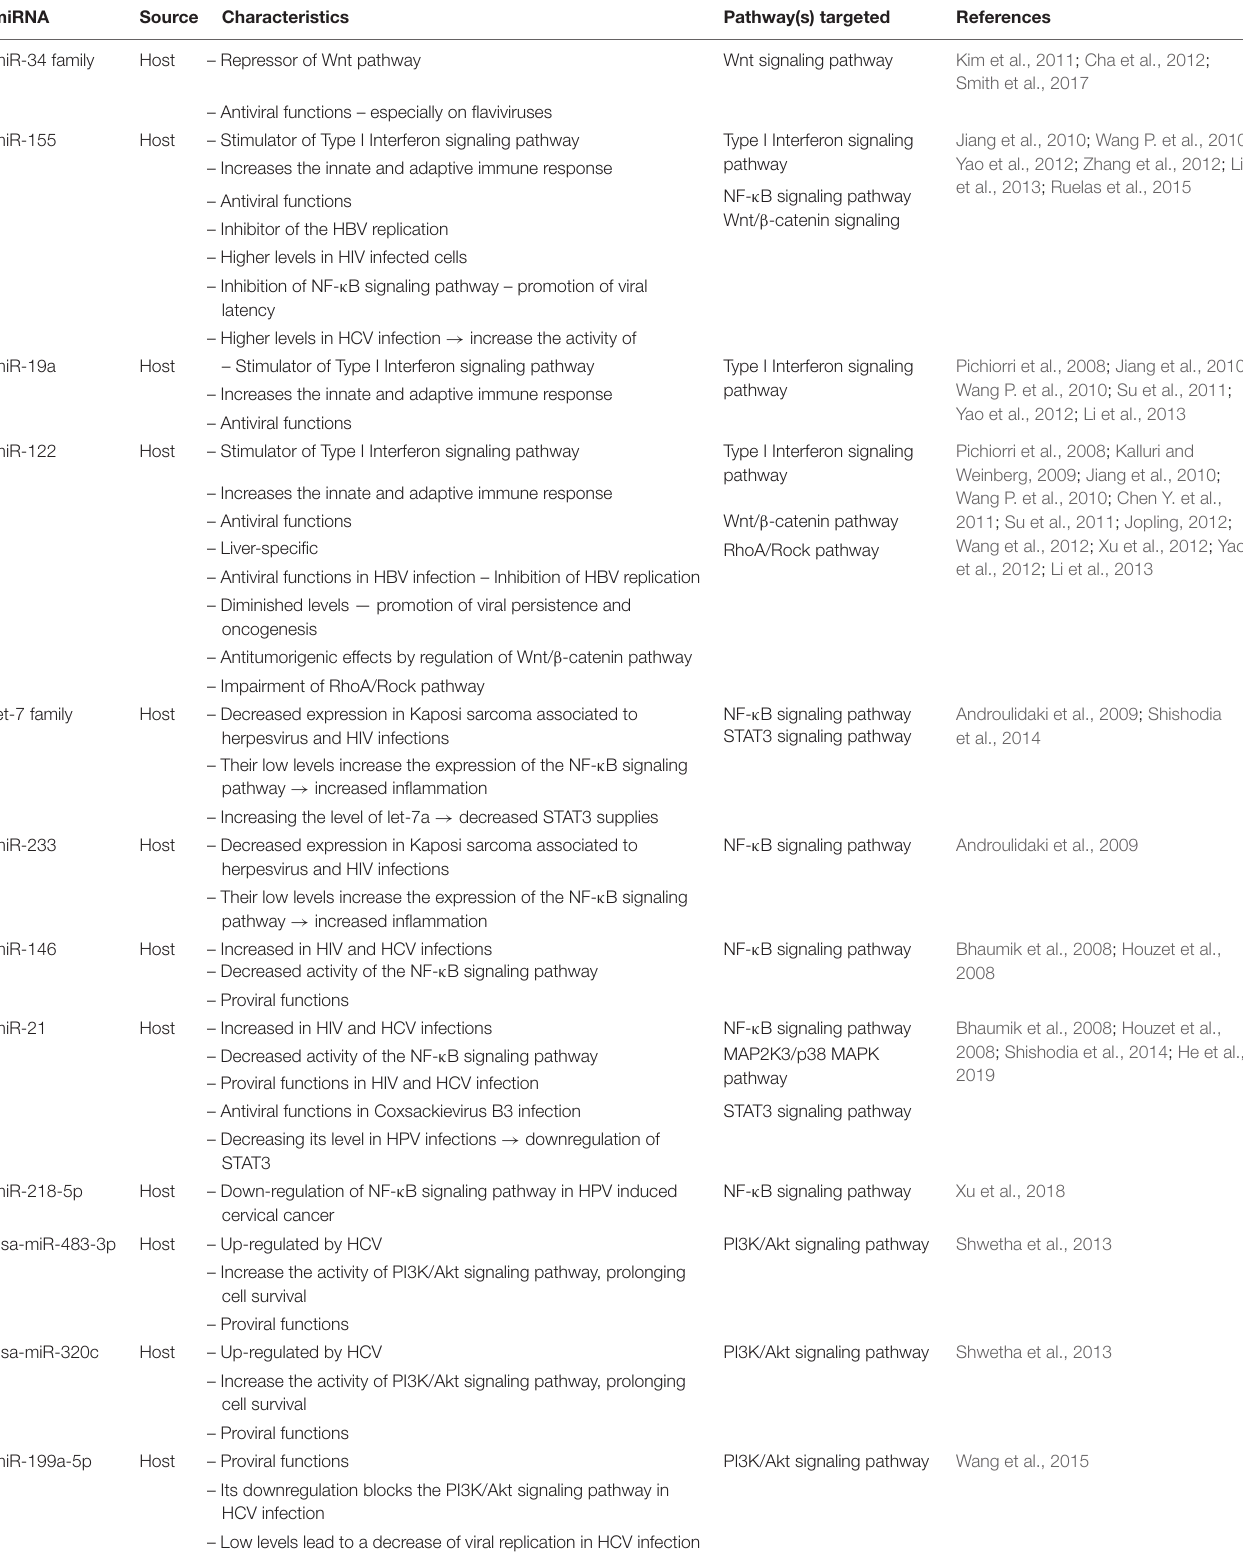
TABLE 2 | Classification, functions and targeted signaling pathways by miRNA.